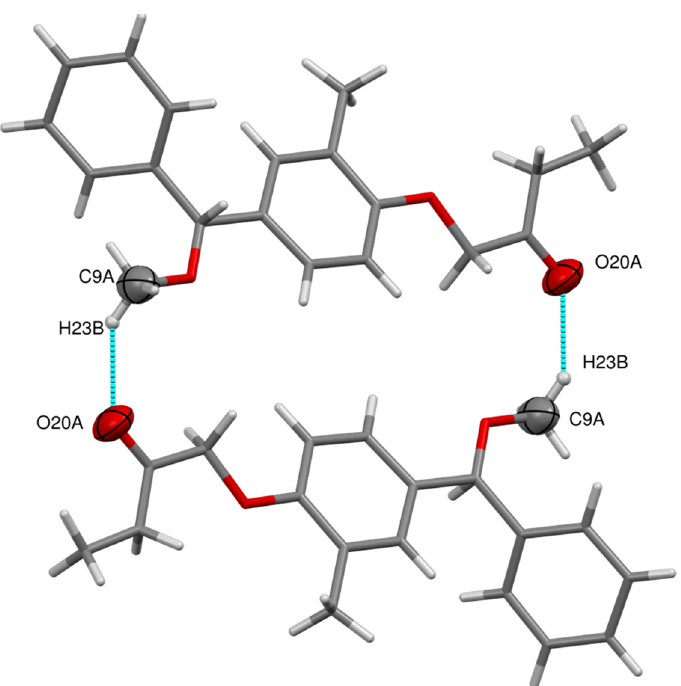
Figure 3. Molecular packing showing C-H…O interactions. Table 1. Crystal data and structure refinement for 3.